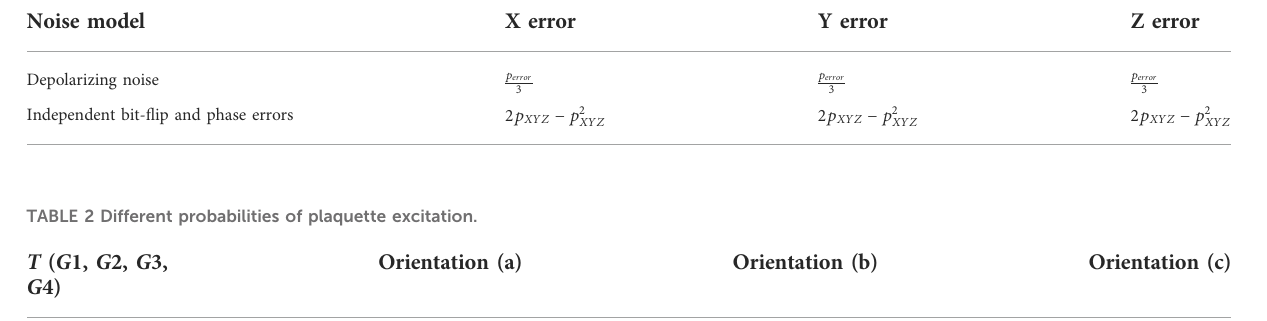
TABLE 1 Error model.